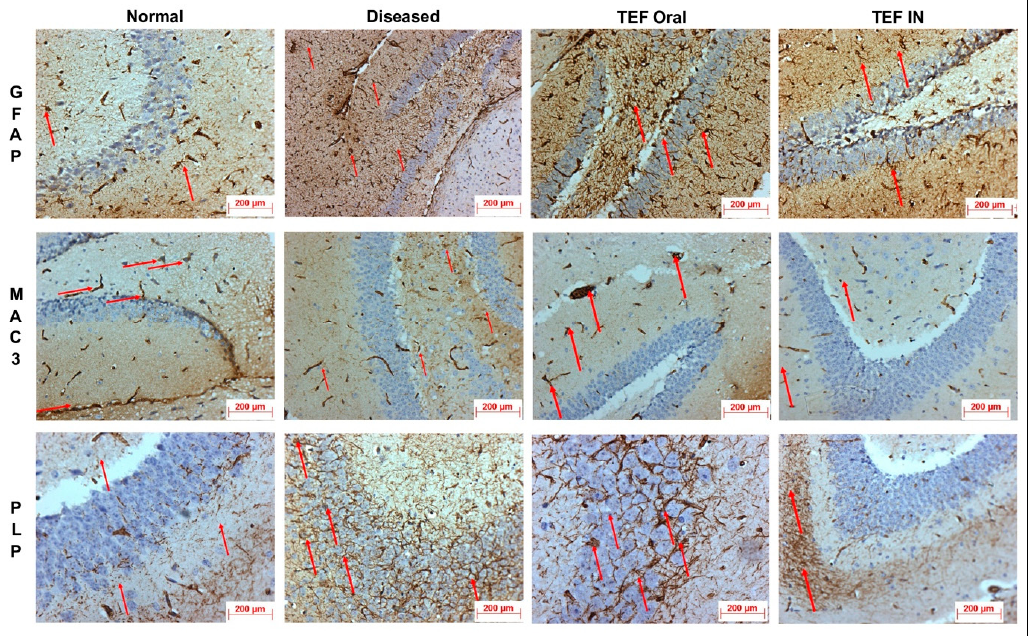
Figure 10. The sections of hippocampus. The degree of astrocytosis was measured by IHC of the study groups by GFAP protein immunoreactivity. The macrophages and microglia were measured by IHC of the study groups by MAC3 protein immunoreactivity. The degree of myelin loss was measured by IHC of the study groups by PLP protein immunoreactivity. The images inferred that– IN-administered TEF–miR-155-antagomir-loaded NLCs group has exhibited signi fi cant recovery with minimal immunopositive reactivity compared to TEF oral group. (Red arrows indicate immu- noreactivity).